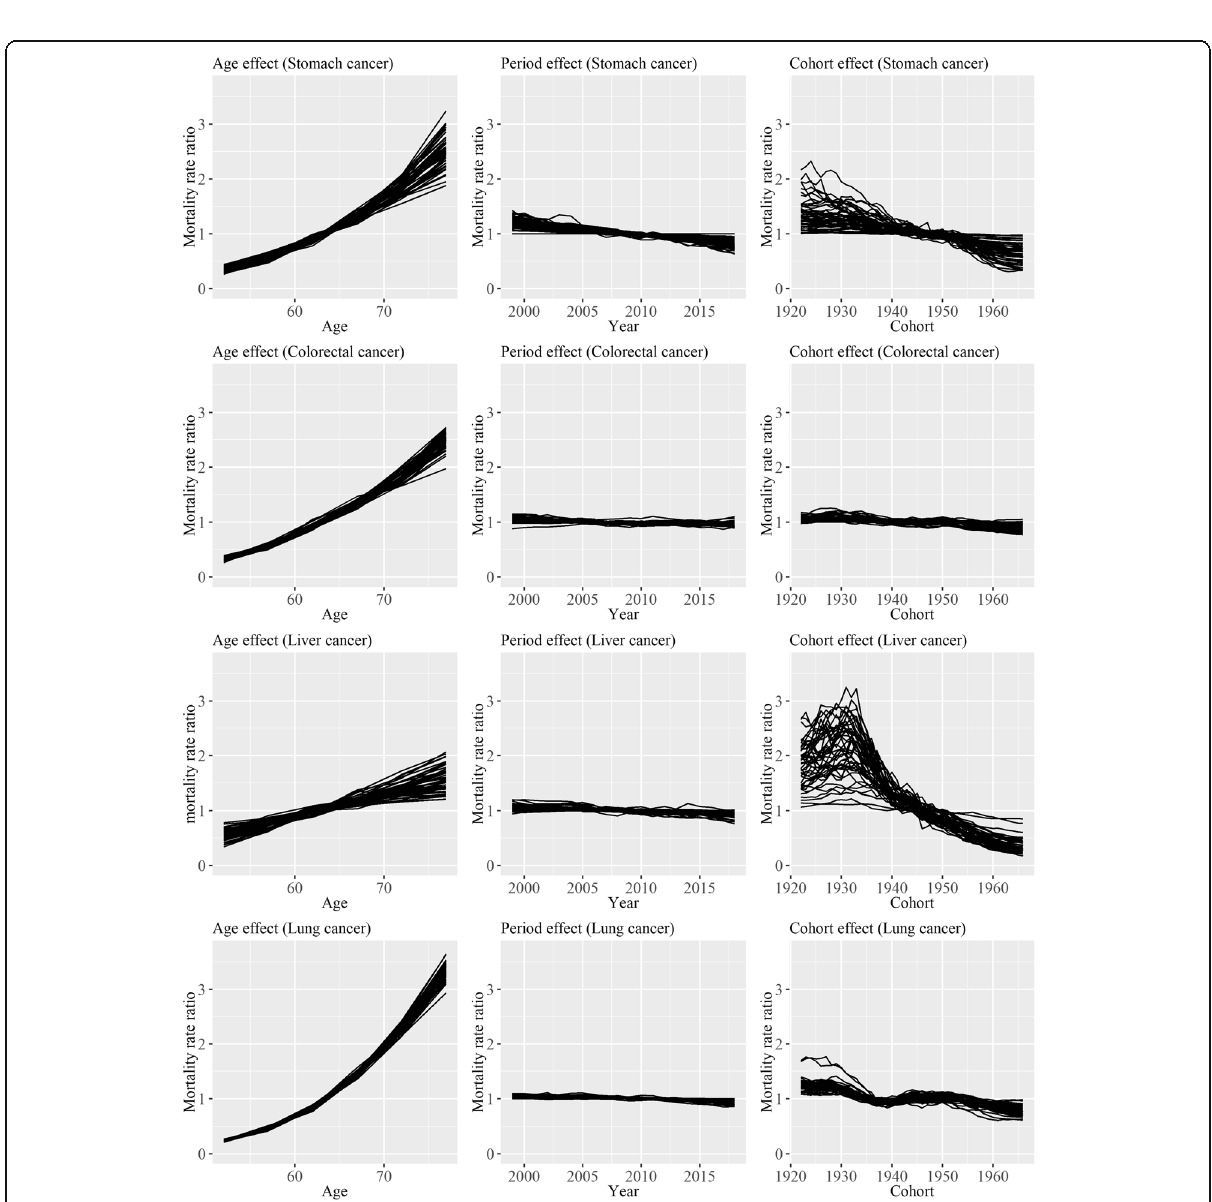
Fig. 1 Age, period, and cohort effects of 47 prefectures for each type of cancer in men. Each line signifies point estimates of each effect for each prefecture, and values of time points in an effect are connected for each prefecture. Regarding age effect, the value for each 5-year age group is assigned to the midpoint of each 5-year age